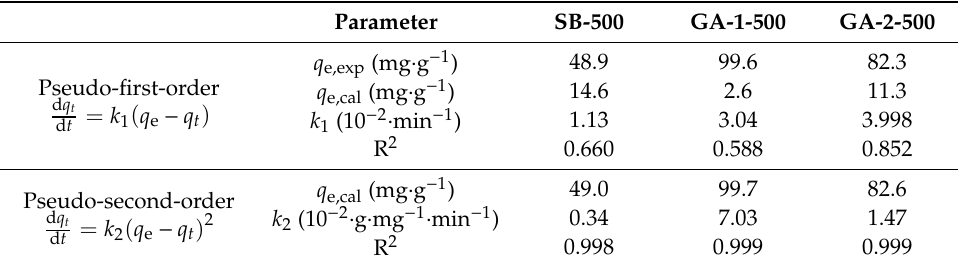
Table 1. Kinetic model parameters of phosphorus adsorption on alumina adsorbents.